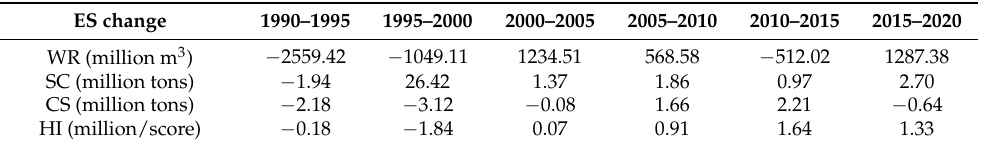
Table 4. Temporal changes of water retention, soil conservation, carbon sequestration, and habitat improvement in six periods.